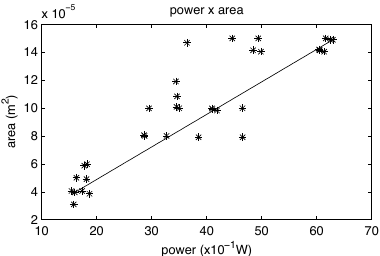
Fig. 7. Trade-off time × area for TG in Fig. 6